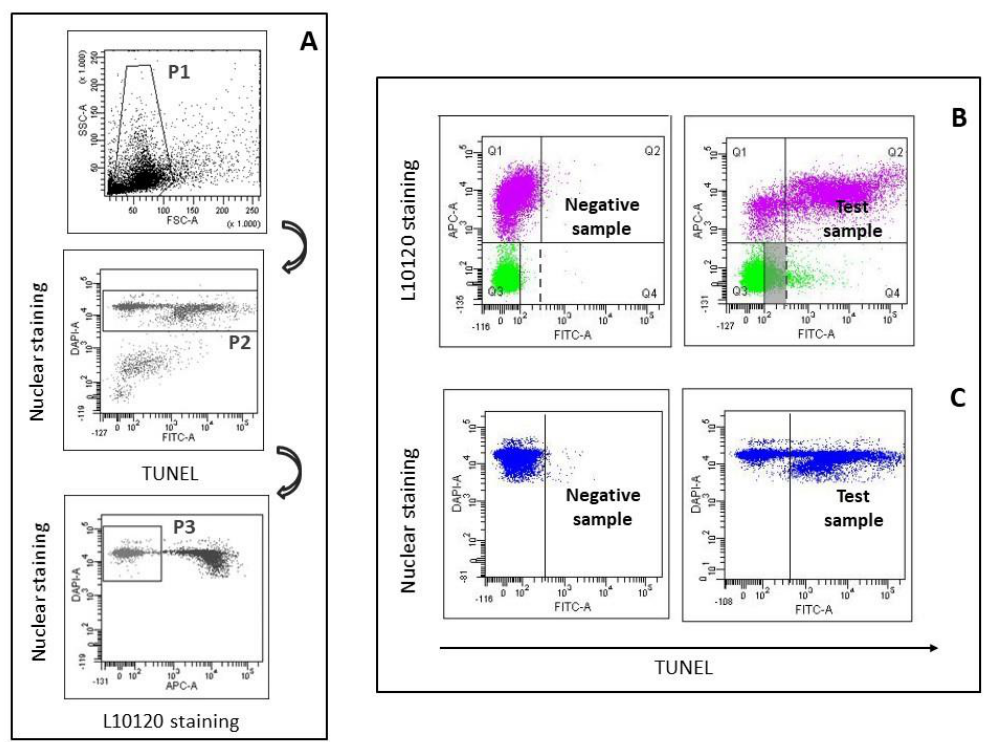
Figure 1. LiveTUNEL (terminal deoxynucleotidyl transferase (TdT)-mediated fluorescein-dUTP nick end labeling). ( A ) Gating strategy. Spermatozoa of native semen samples were gated within the Forward Scatter/Side Scatter flame shaped region (P1, upper panel) and then within the region containing DAPI-labelled events (P2, middle panel). Within spermatozoa, a further gate was drawn delimitating viable sperm (P3, lower panel) used during flow cytometric acquisition. ( B ) Typical L10120/TUNEL dot plots reporting DNA fragmentation in viable (green) and non-viable (pink) spermatozoa. Left panel: negative control, right panel: test sample. Note that non-specific fluorescence of the negative control (absence of TdT, left panel) was higher in non-viable than in viable spermatozoa. Grey region, fraction of viable sperm DNA fragmentation (sDF) that can be masked in traditional TUNEL assay. ( C ) Total sDF was calculated by gating total spermatozoa (blue), without discriminating viable and non-viable cells, in DAPI/TUNEL dot plots (left panel: negative control; right panel: test sample).